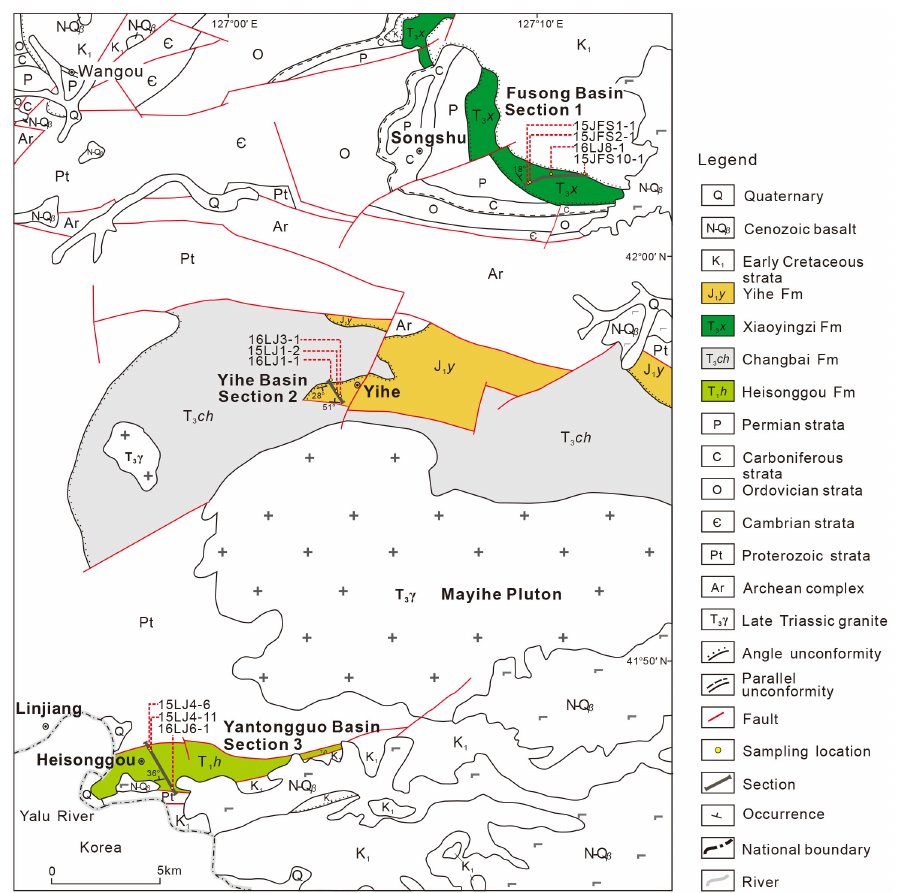
Figure 2. Geological map of the Linjiang area showing early Mesozoic strata and the three study